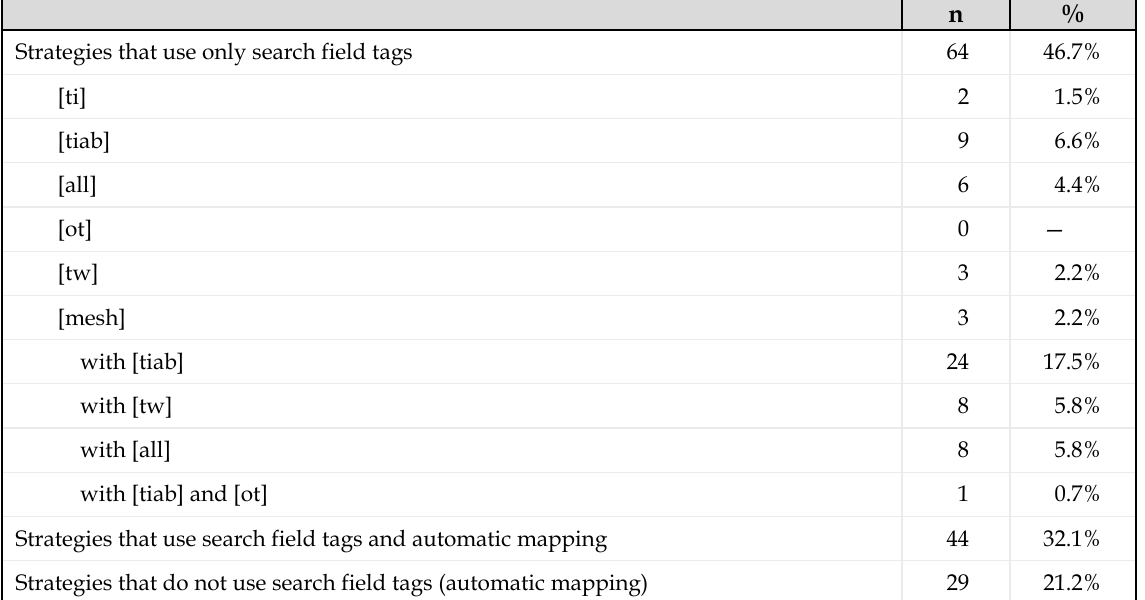
Strategies that use only search field